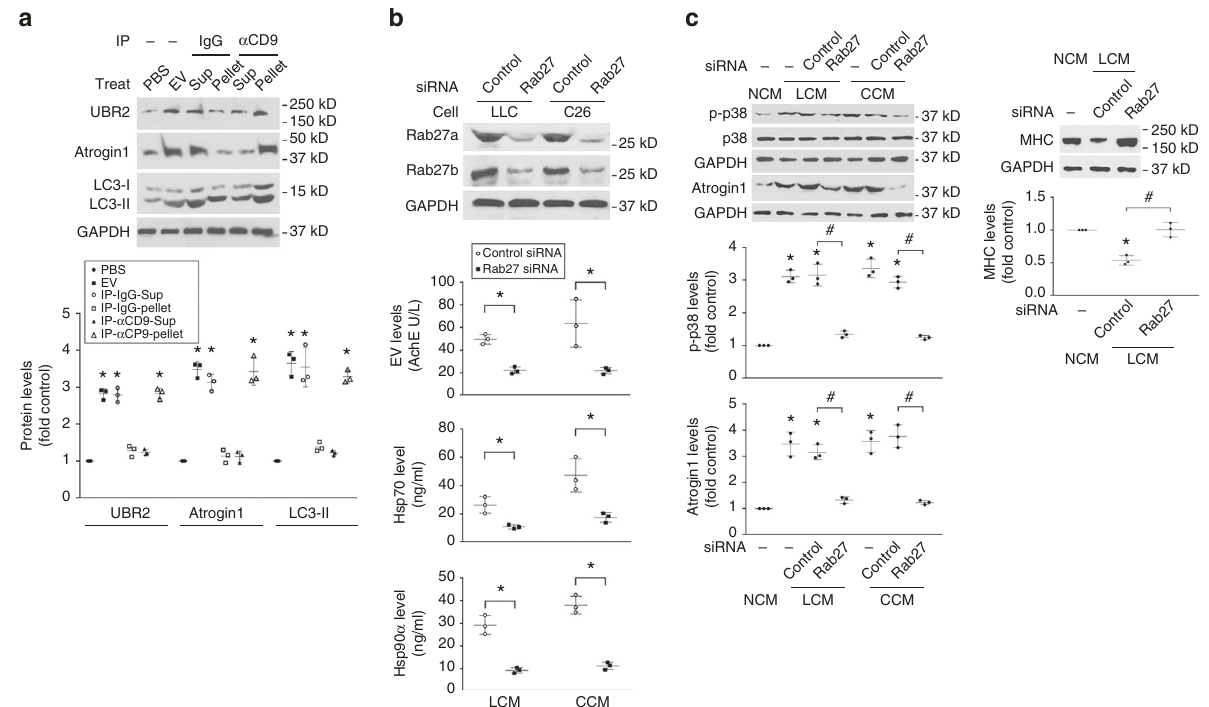
Fig. 6 Tumor cell-released Hsp70/90-expressing EVs induce muscle catabolism in myotubes. a CD9-positive EVs induce catabolic response in C2C12 myotubes. EVs isolated from LCM were subjected to immunoprecipitation (IP) against CD9 with pre-immune IgG as control. Resulted pellet and supernatant (Sup) were used to treat C2C12 myotubes and compared with PBS and input EVs for catabolic activity using western blotting. Data ( n = 3) were analyzed by analysis of variance (ANOVA) and * denotes a difference from PBS treatment ( P < 0.05). b Hsp70/90 release by cachexia-inducing tumor cells is dependent on EV release. Rab27a and Rab27b were knocked down by transfecting LLC and C26 cells with control or speci fi c siRNAs. EVs and Hsp70/90 released into conditioned media were quanti fi ed after Brij98 treatment. EVs were quanti fi ed by AchE. Data ( n = 3) were analyzed by Student t -test. c Tumor cell-induced catabolic response in myotubes is dependent on EV release. C2C12 myotubes were treated with conditioned media of Rab27- de fi cient LLC or C26 cells and analyzed for p38 MAPK activity (at 1 h), atrogin1 (at 8 h) and MHC levels (72 h). Conditioned medium of non-tumorigenic NL20 cells (NCM) was used as control. Data ( n = 3) were analyzed by ANOVA. * denotes a difference ( P < 0.05) from